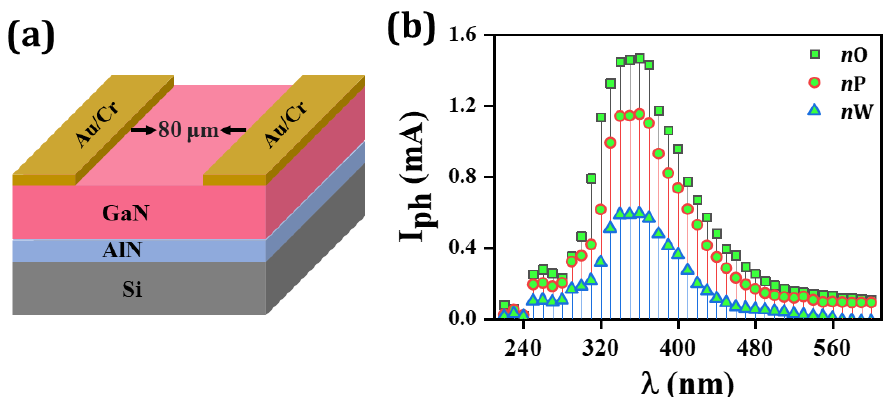
Figure 5. ( a ) A schematic of the fabricated device structure and ( b ) a comparison of the spectral response of heterostructures grown on different AlN buffer layer temperatures (nO, nP, and nW).